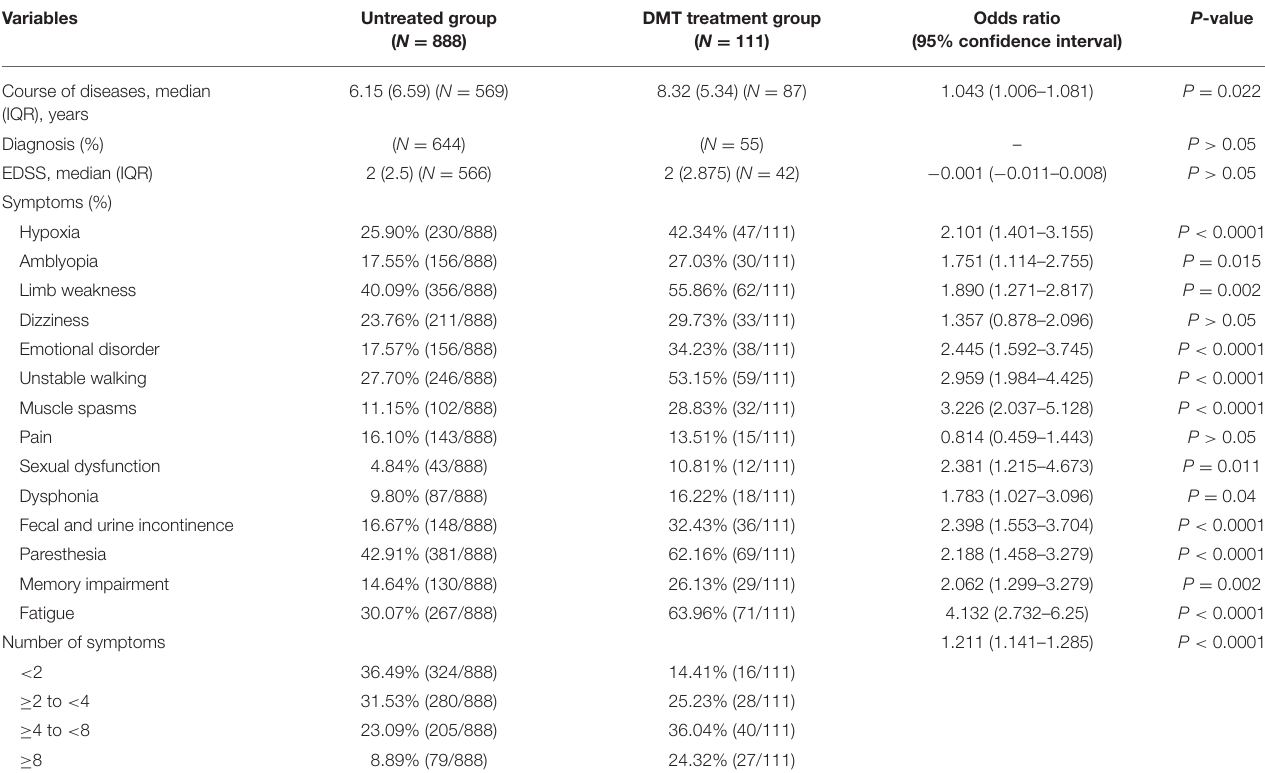
TABLE 7 | Disease characteristics of the DMT treatment group and untreated